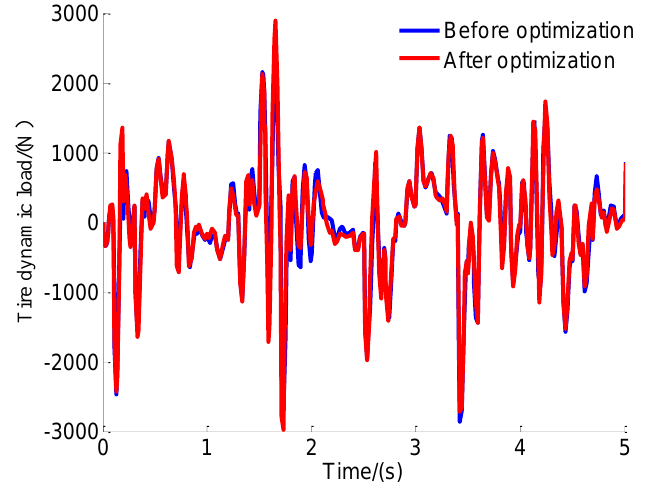
Figure 10. Tire dynamic load response curve.